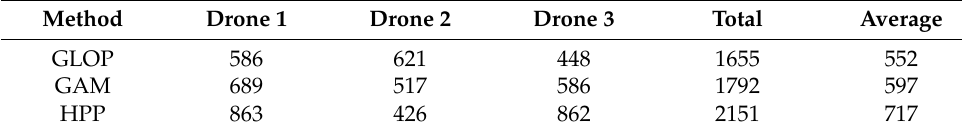
Table 8. Flight Time (seconds).